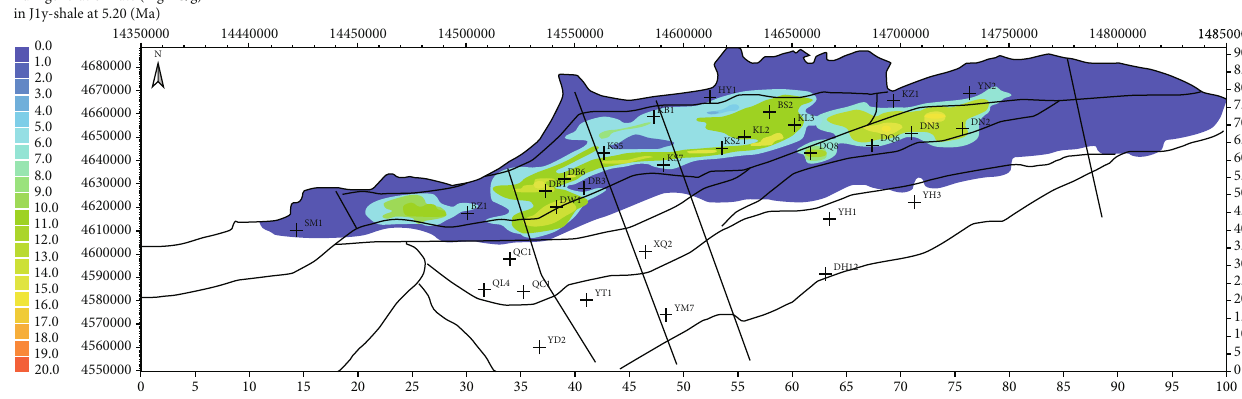
Figure 13: The bulk hydrocarbon generation rate of J